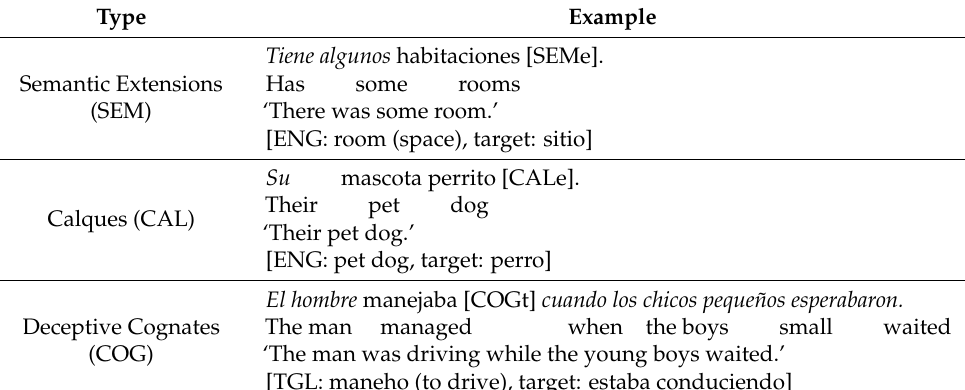
Table 3. Meaning-based CLI.